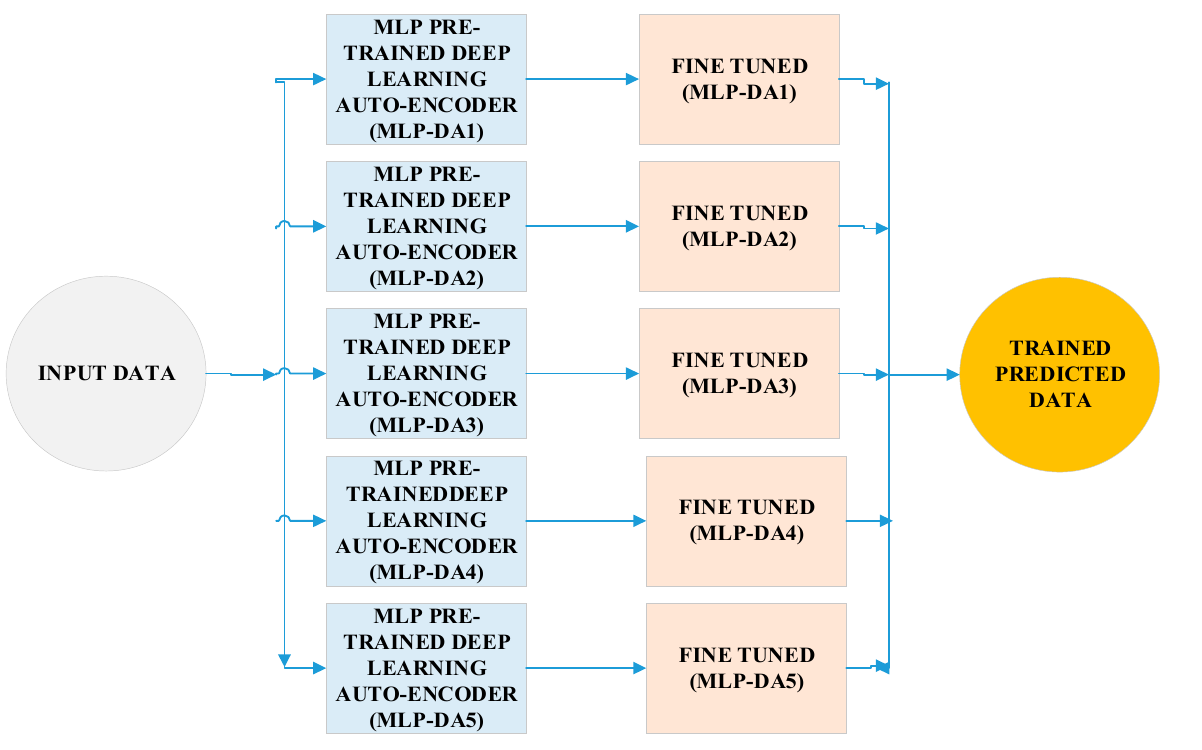
Figure 2. MLP Auto-Encoding Data Flow Graph for the Preprocessing of Wind Data for Wind Power Forecasting.